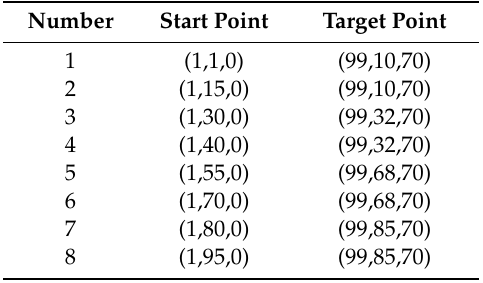
Table 15. Coordinates of the starting and target points of all UAVs (case 4).